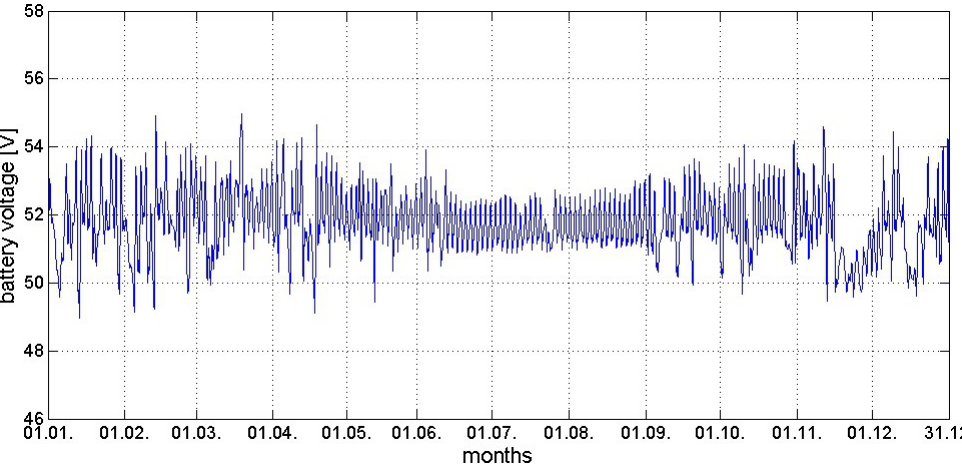
Figure 14. Yearly variation of battery voltage for the BSS C.